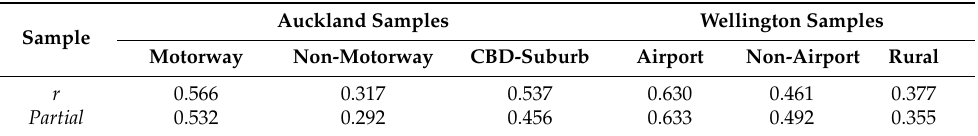
Table 2. Bivariate and partial correlation coefficients representing the relationship between air pollution annoyance and noise annoyance. Partial correlation controls for Age, Education, Gender, Illness and Noise Sensitivity. All coefficients are statistical significant ( p <